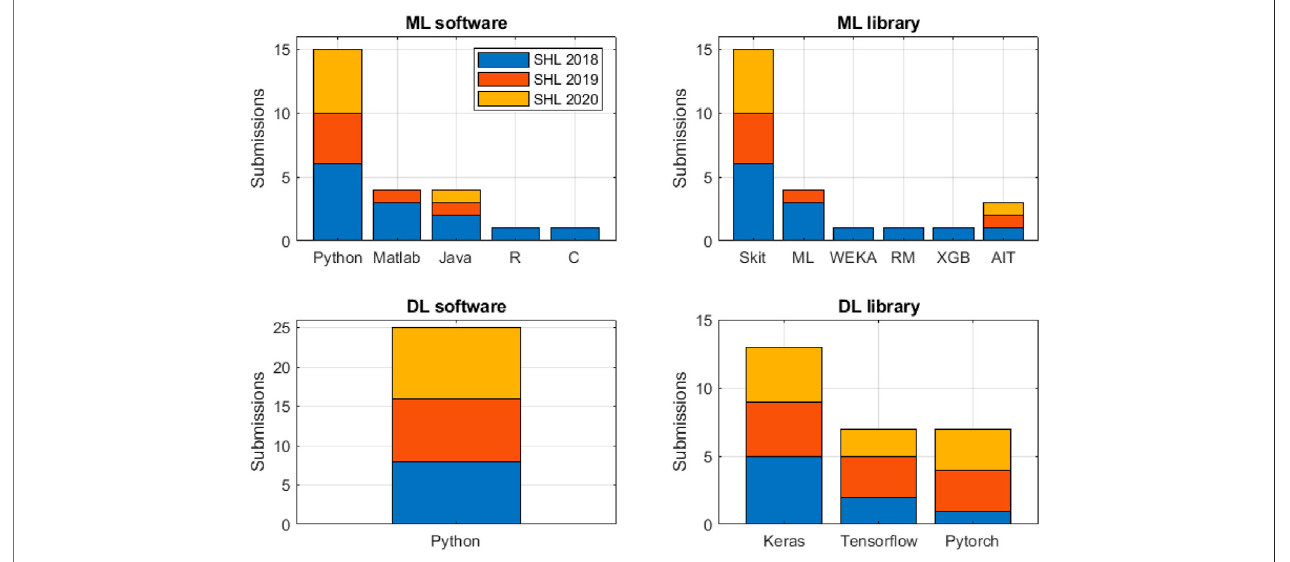
FIGURE 13 | Programming languages and libraries used by the submissions for classical machine learning and deep learning.